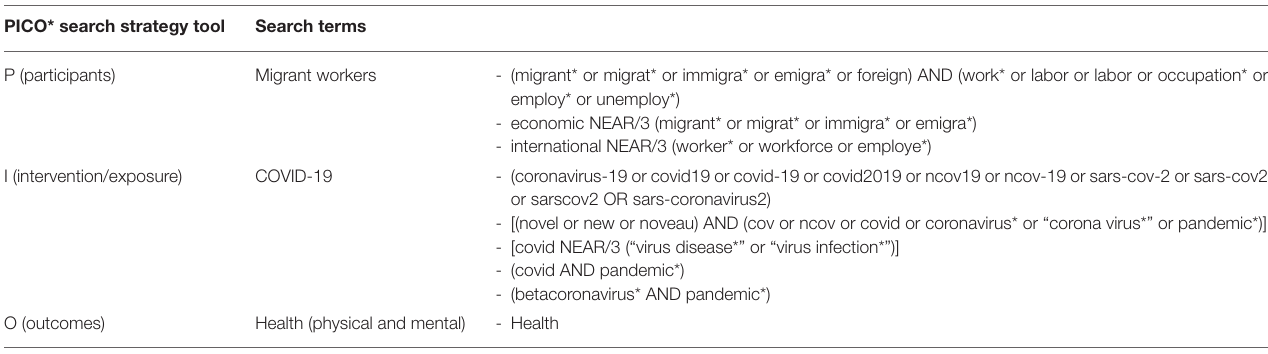
TABLE 1 | PICO search strategy and search terms.